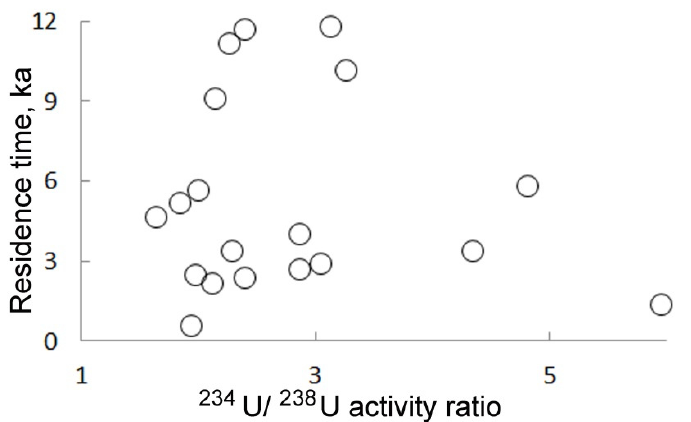
Figure 6. 234 U: 238 U activity ratio vs. groundwater residence time in the fresh groundwater of the study area.